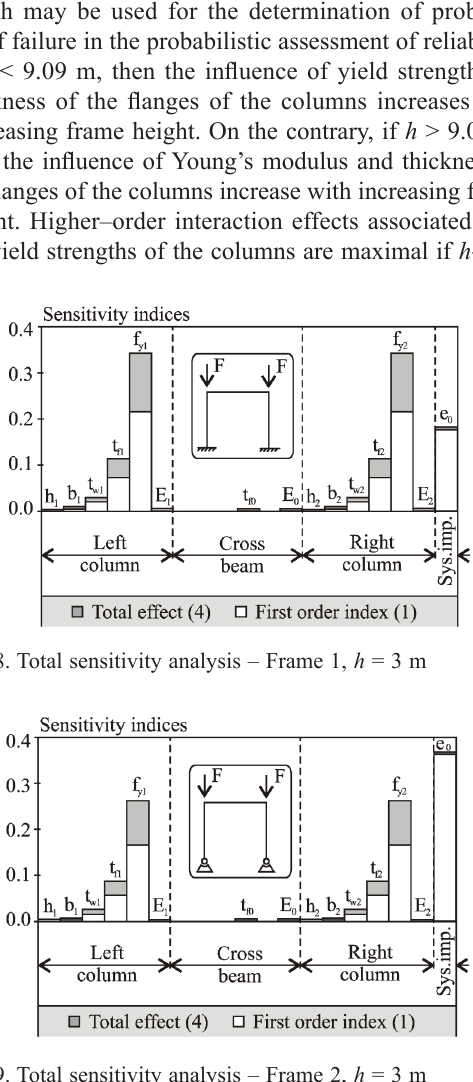
Fig. 6. Sensitivity analysis – Frame 1, h = 3 m